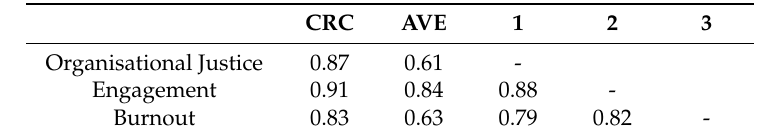
Table 2. Correlations between underlying factors, composite reliability coefficient and average variance extracted.